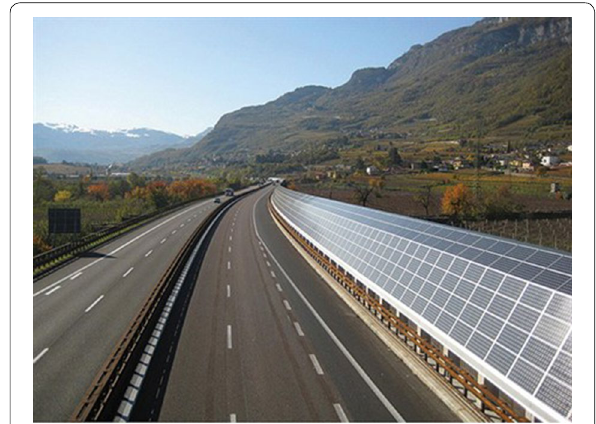
Fig. 15 Photovoltaic railing and guardrails photovoltaic parkings. (Here the Brennero highway in Italy from http://www.autob renne ro.it)